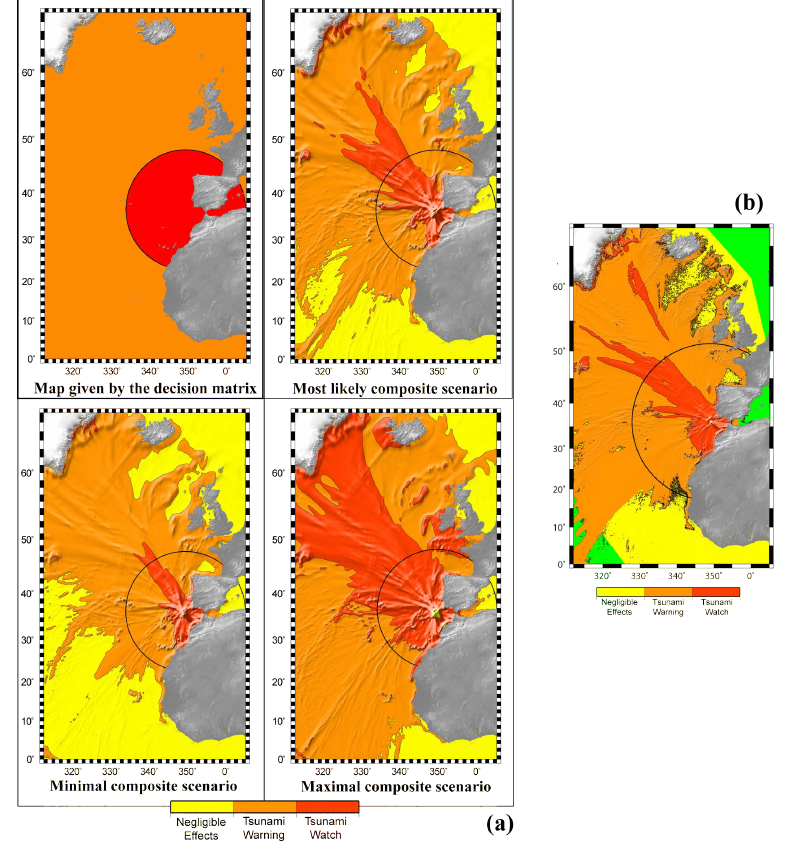
Fig. 15. (a) Result of the model-based tsunami prediction system: final representation destined for the French authorities using the test case of the 1969 Gorringe earthquake ( M w = 7 . 8, Atlantic). Black circle: 1000km radius area around the epicenter (decision matrix parameter). (b) Warning map resulting from “on the fly” tsunami modeling using the source parameters of Grandin et al.